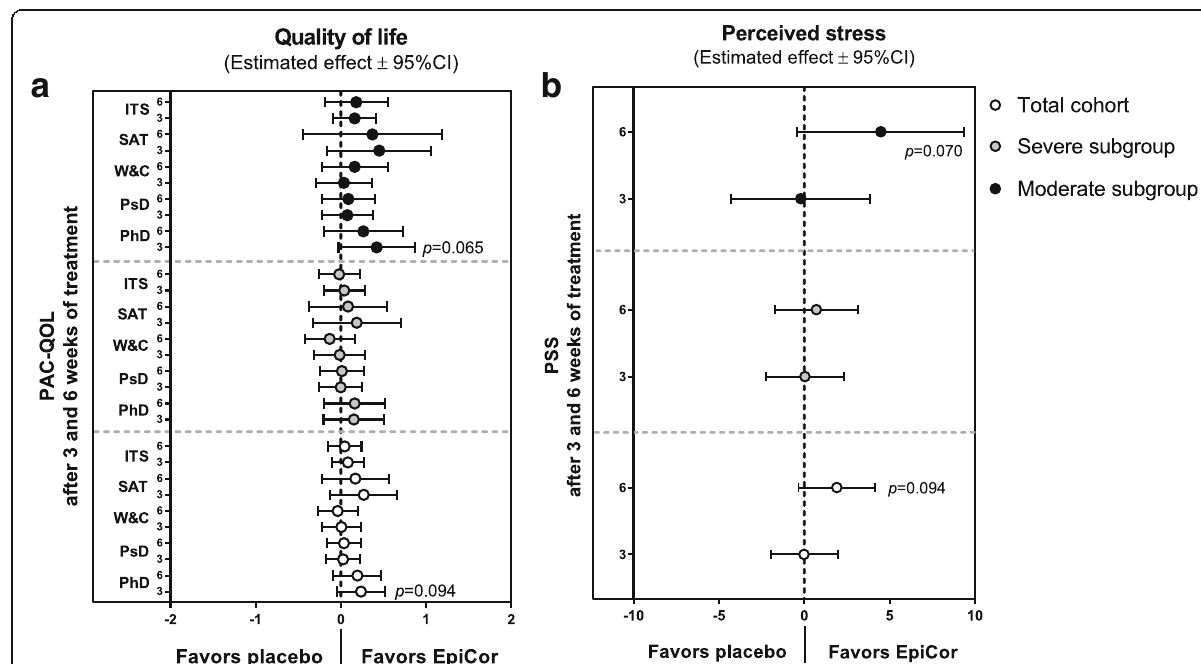
Fig. 5 Mean differences between EpiCor and placebo on constipation-associated quality of life ( a ) and perceived stress ( b ) on the three cohorts. Legend: The enlisted Patient Assessment of Constipation Quality of Life (PAC-QOL) items are PhD (physical discomfort), PsD (psychosocial discomfort), W&C (worries and concerns) and SAT (satisfaction). An instrument total score (ITS) calculated as the average of all 28 items recorded at each visit is also shown. PSS relates to the Perceived Stress Scale instrument. A linear mixed model analysis that takes into account the differences between groups at baseline was used (no p -values <0.05 were found; p -values <0.1 are depicted in regular